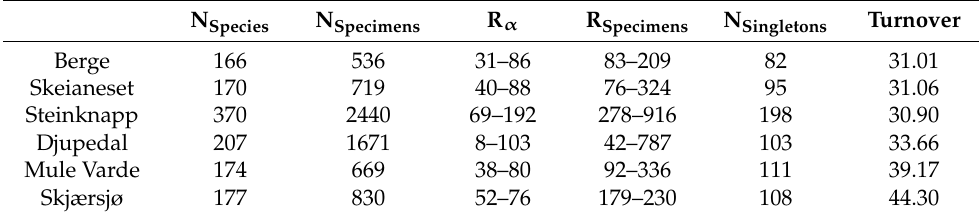
Table 2. Site diversity data. N Species = Number of species collected from the site. N Specimens = Number of specimens collected from the site. R α = Range of species numbers collected from any tree within the site. R Specimens = Range of specimens collected from any tree within the site. N Singletons = Number of species represented by one specimen only. Turnover = Whittaker’s β within the site.